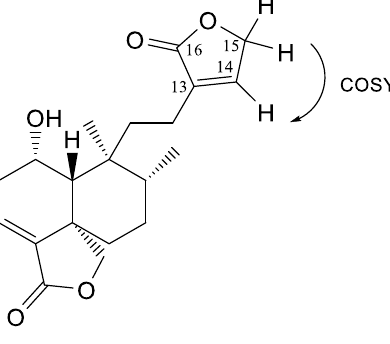
Figure 3. Correlations of compound 5 . 149